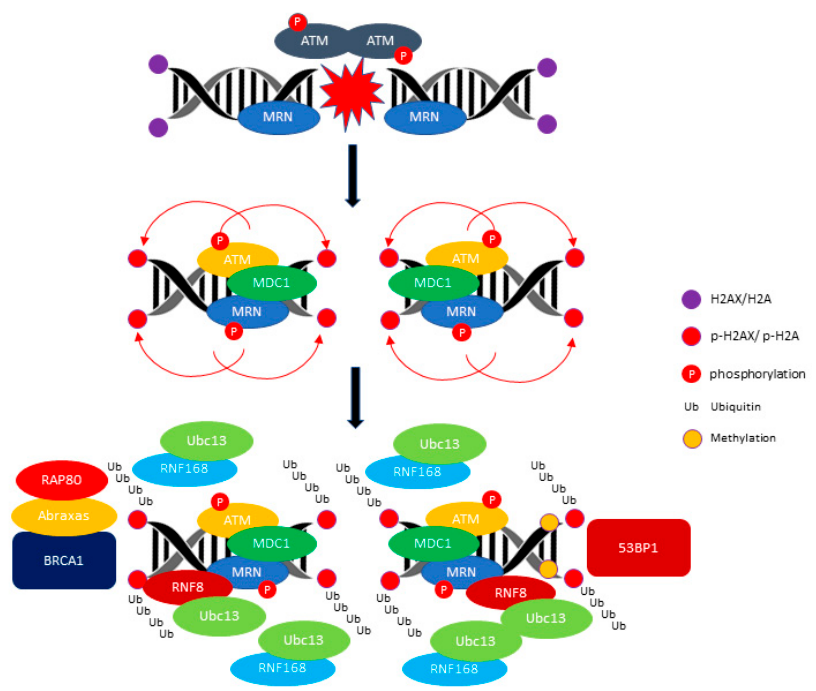
Figure 1. ATM (ataxia telangiectasia mutated)-mediated DDR (DNA damage response) signaling pathway. ATM phosphorylates H2AX/H2A and promotes the recruitment of E3 ubiquitin-protein ligase RNF8 (RNF8) and E3 ubiquitin-protein ligase RNF168 (RNF168) ubiquitin ligase. The RNF8 and RNF168 mediate the polyubiquitination of Histone H2A/ H2AX (H2AX/H2A) and recruit the BRCA1/RAP80/Abraxas for activation of the HR (homologous repair) pathway. The recruitment of TP53-binding protein 1 (53BP1) requires the methylation of the histone H4 Lysine 20. The red arrow indicates the phosphorylation of H1, H2A and H2AX events and the black arrow indicates the progression events take place at DNA breakage sites.